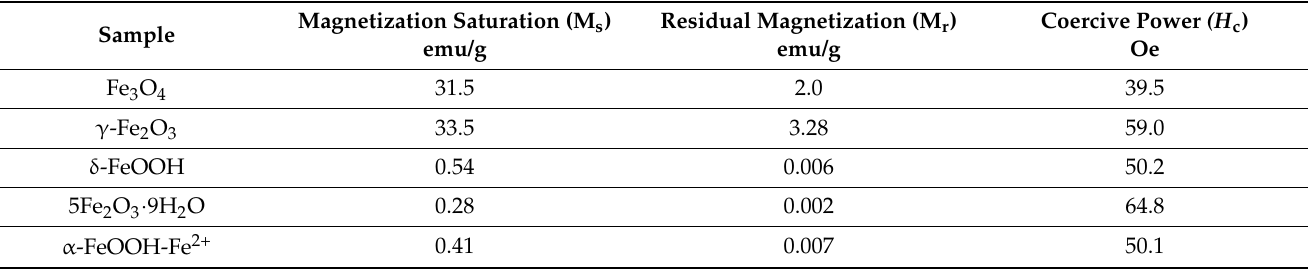
tion. The α -FeOOH-Fe 2+ sample has a hysteresis loop of the H4 type. The 5Fe 2 O 3 ·9H 2 O has